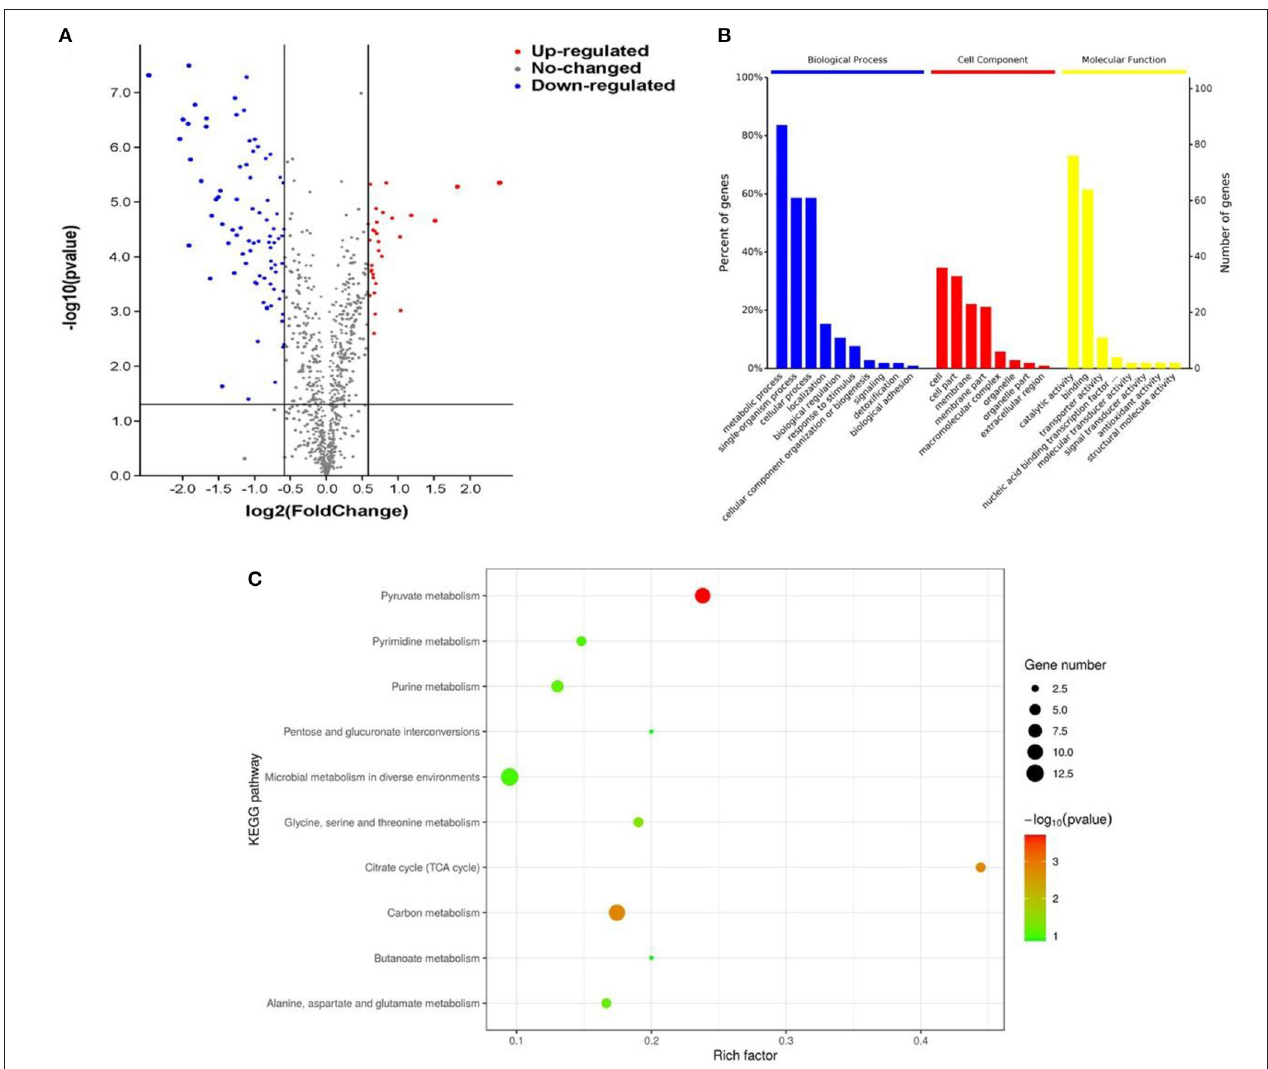
FIGURE 4 | The effects of L. plantarum KM1 on the protein level under the stress of H 2 O 2 . Changes in protein levels (A) , functional classification of the Gene Ontology (GO) (B) and the distribution of differentially expressed proteins in the Kyoto Encyclopedia of Genes and Genomes (KEGG) pathway (top 10) (C) in L. plantarum KM1 under H 2 O 2 stress. Red: upregulate differentially expressed proteins; blue: downregulate differentially expressed proteins.